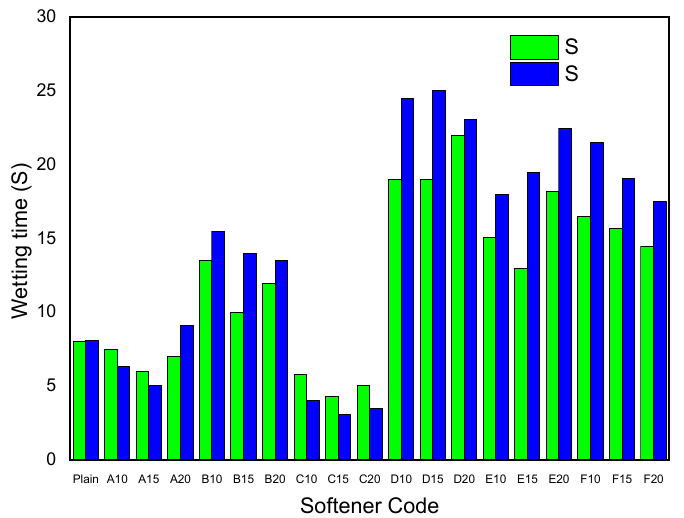
Figure 2. Wetting index of terry knitted fabric with the application of different softeners. Table 3. Effect of Softener type and concentration on wetting time, absorption, and spreading speed of the fabric. Wetting Time Softener Code (Bottom)